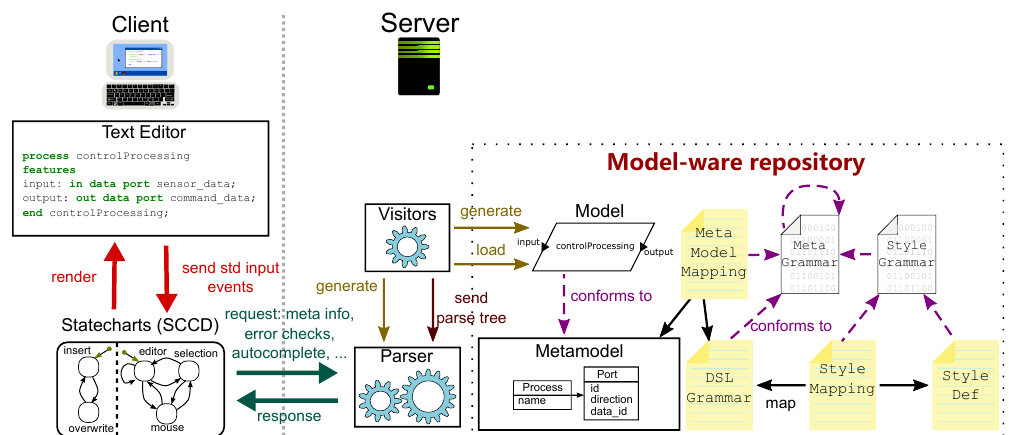
Figure 1. Overview of the main components of the architecture and their